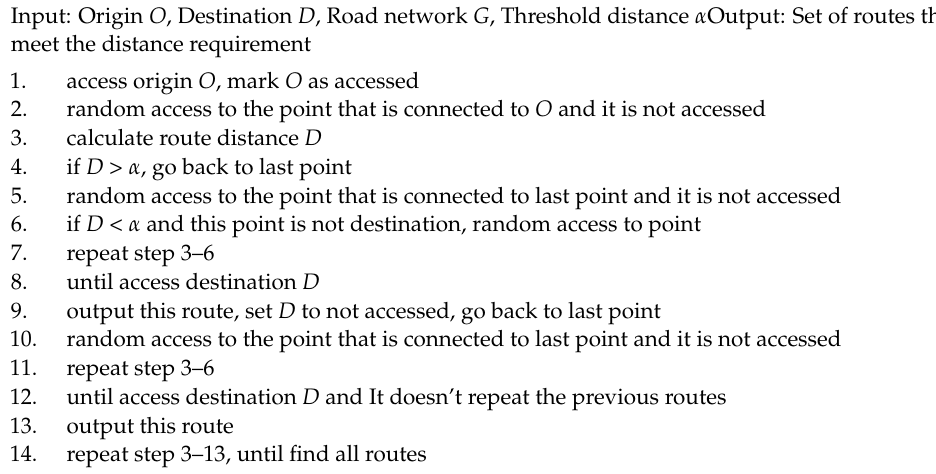
Algorithm 2 Pruning algorithm based on depth-first search for traversal segment of two points